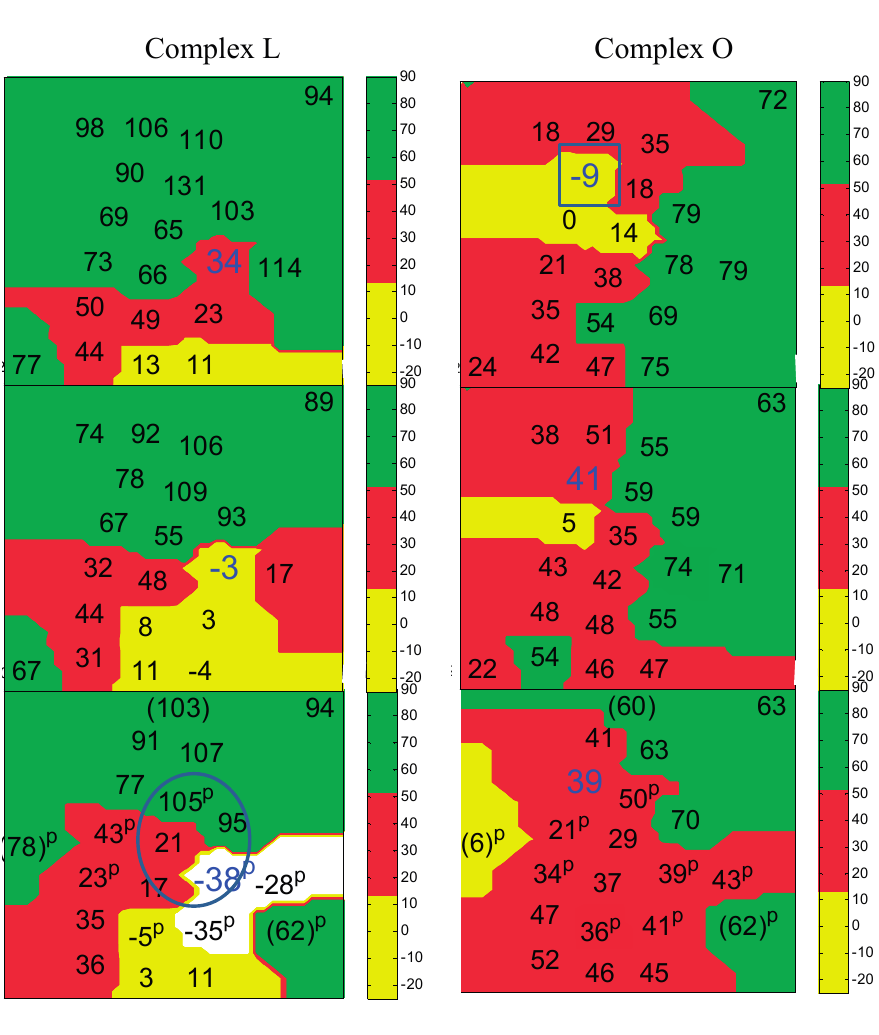
Figure 2. Cont. Complex L Complex